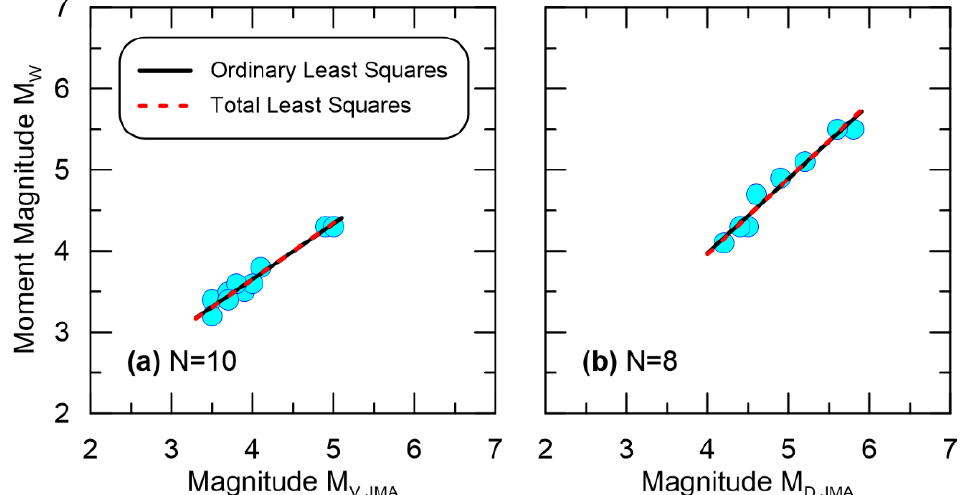
Figure 5. Relationships between M w and ( a ) M V and ( b ) M D by JMA. The solid and dashed lines represent the regression type as indicated in the graph. N is the number of data points used for regression.